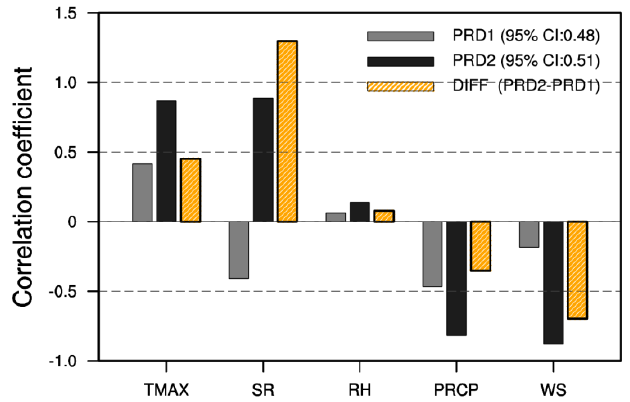
Figure 5. Correlation coefficients between annual O 3 and meteorological factors during the period